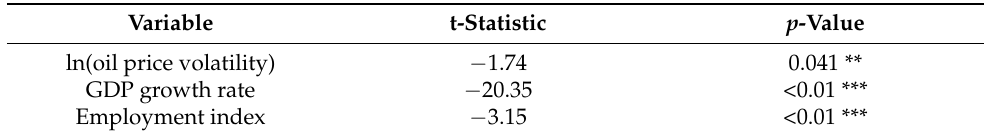
Table 1. Im–Peasaran–Shin test for stationarity.